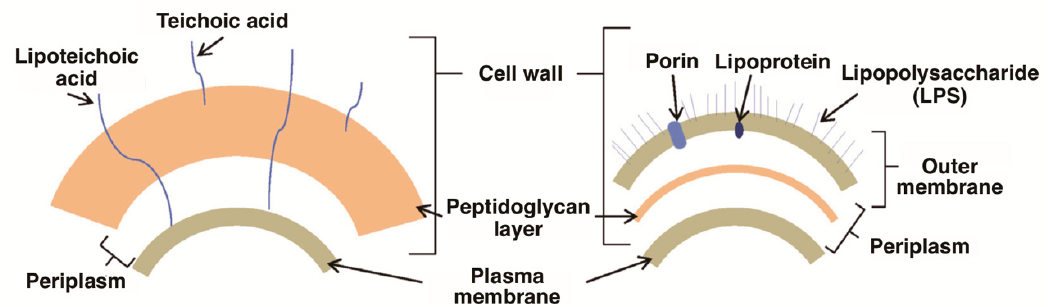
Figure 3. Schematic representation of the cellular envelope of Gram-(+) ( left ) and Gram-( − ) bacteria ( right ). Reproduced from Reference [21] with permission of Elsevier.